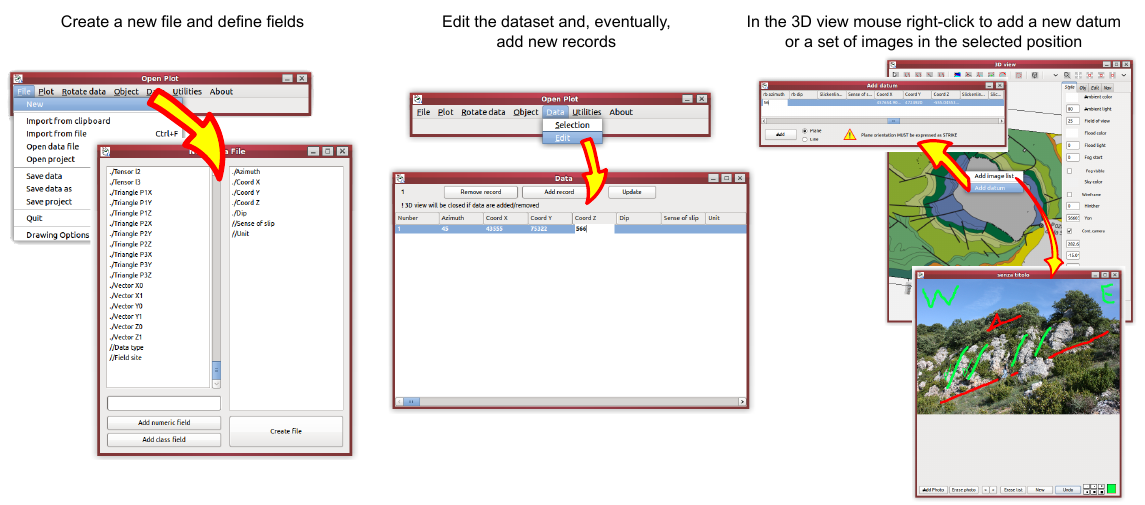
Fig. 4. Procedures to introduce data and photos of outcrops in Open Plot